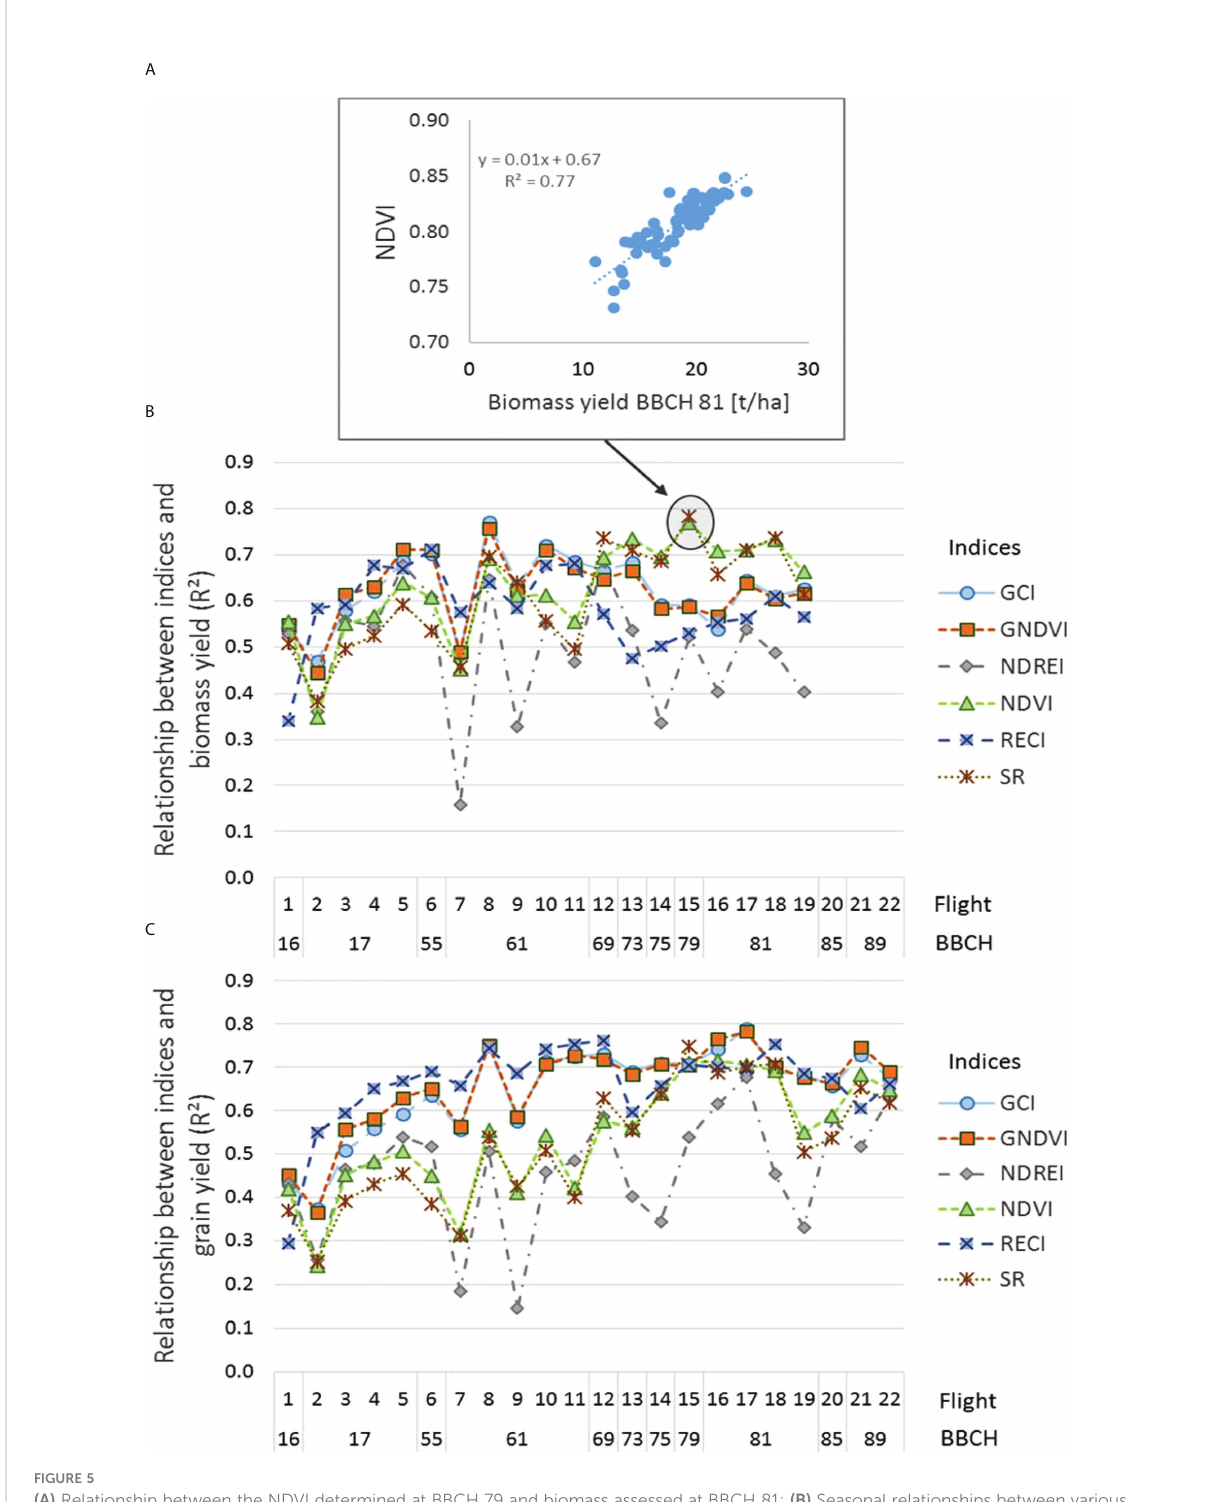
FIGURE 5 (A) Relationship between the NDVI determined at BBCH 79 and biomass assessed at BBCH 81; (B) Seasonal relationships between various indices and biomass at BBCH 81 indicated as Pearson coef fi cients of determination (R²); (C) Seasonal coef fi cients of determination (R²) between grain yield and various